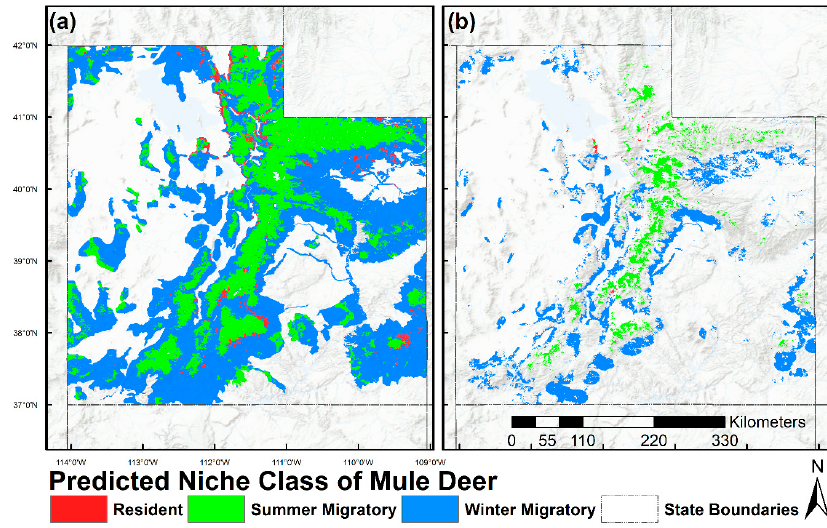
Figure 5. Predicted migratory and resident niche classes in Utah. ( a ) Random forest classification across the entire state within known mule deer habitat. ( b ) Random forest classification where there was high certainty in prediction (proportion of agreed classes greater than 0.8). Red designates areas discriminated as resident niches, blue designates winter migratory niches, and green designates summer migratory niches.